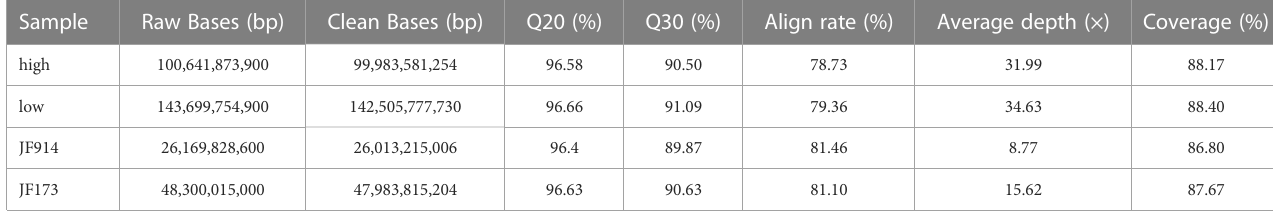
TABLE 2 Sequence data of the parents and pools.